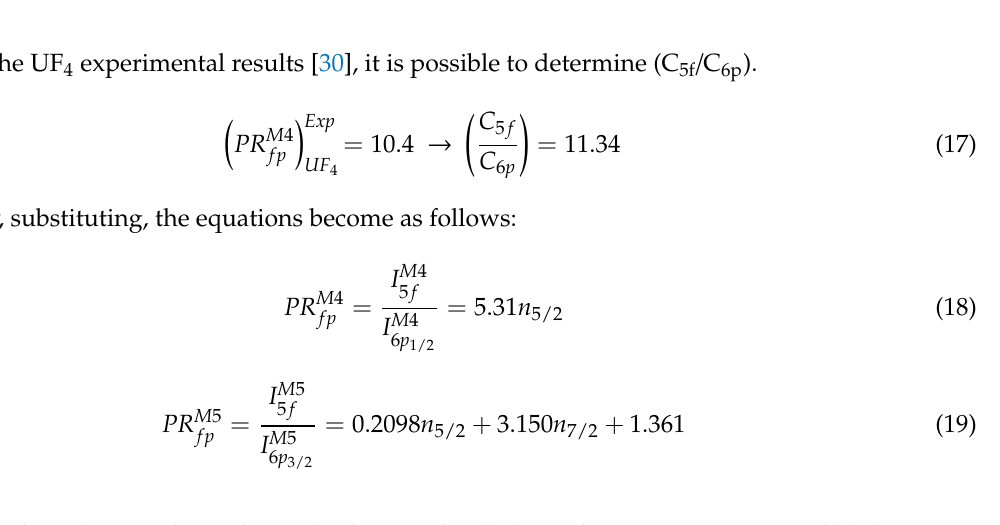
Table 4. Shown here are the 6p electric dipole. Note that (1) the total 6p cross section is 4; and (2) the 6p cross section per 3d hole is 2 / 5. Leftmost are the results for completely empty 3d states. Rightmost are the cross sections per 3d hole. See text for details.